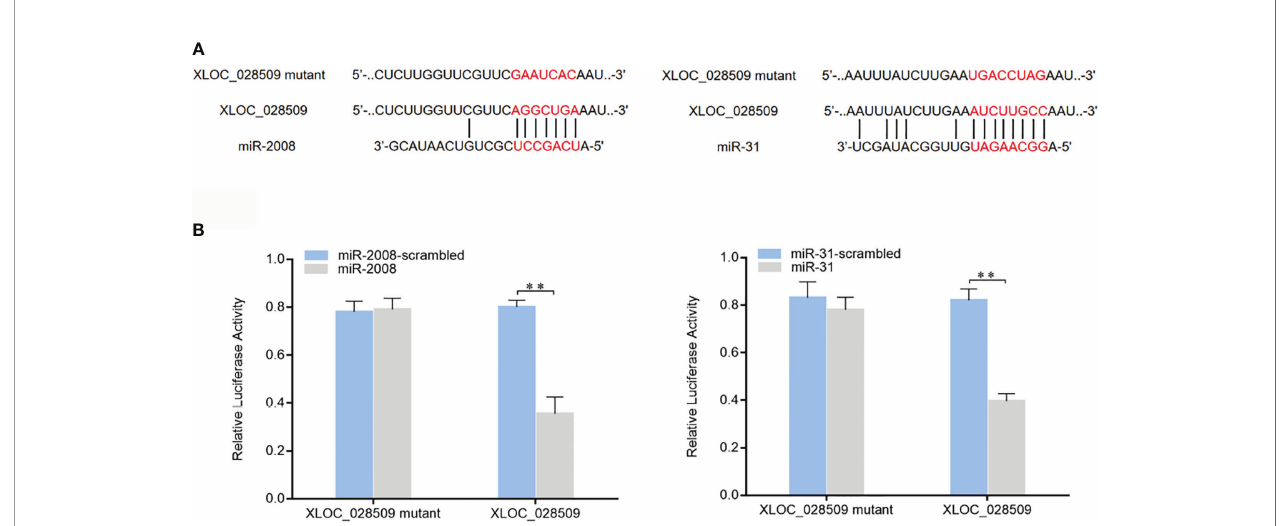
FIGURE 5 | Interaction analysis of the differentially expressed lncRNA and miRNAs. (A) Schematic diagram of lncRNA XLOC_028509 binding to miR-2008 and miR-31, the red letters indicated the direct binding sites of miRNAs with XLOC_028509 and the respective mutant sites. (B) Direct interaction between lncRNA XLOC_028509 and miRNAs. HEK-293T cells were co-transfected with target miRNAs and a luciferase reporter fused with XLOC_028509. At 36 h after co-transfection, the luciferase activities were examined. The activity of renilla luciferase was normalized to that of fi re fl y luciferase. As controls, control miRNAs and mutants of XLOC_028509 were included in the co-transfections. Error bars indicate the means ± SD of three independent experiments (** p <